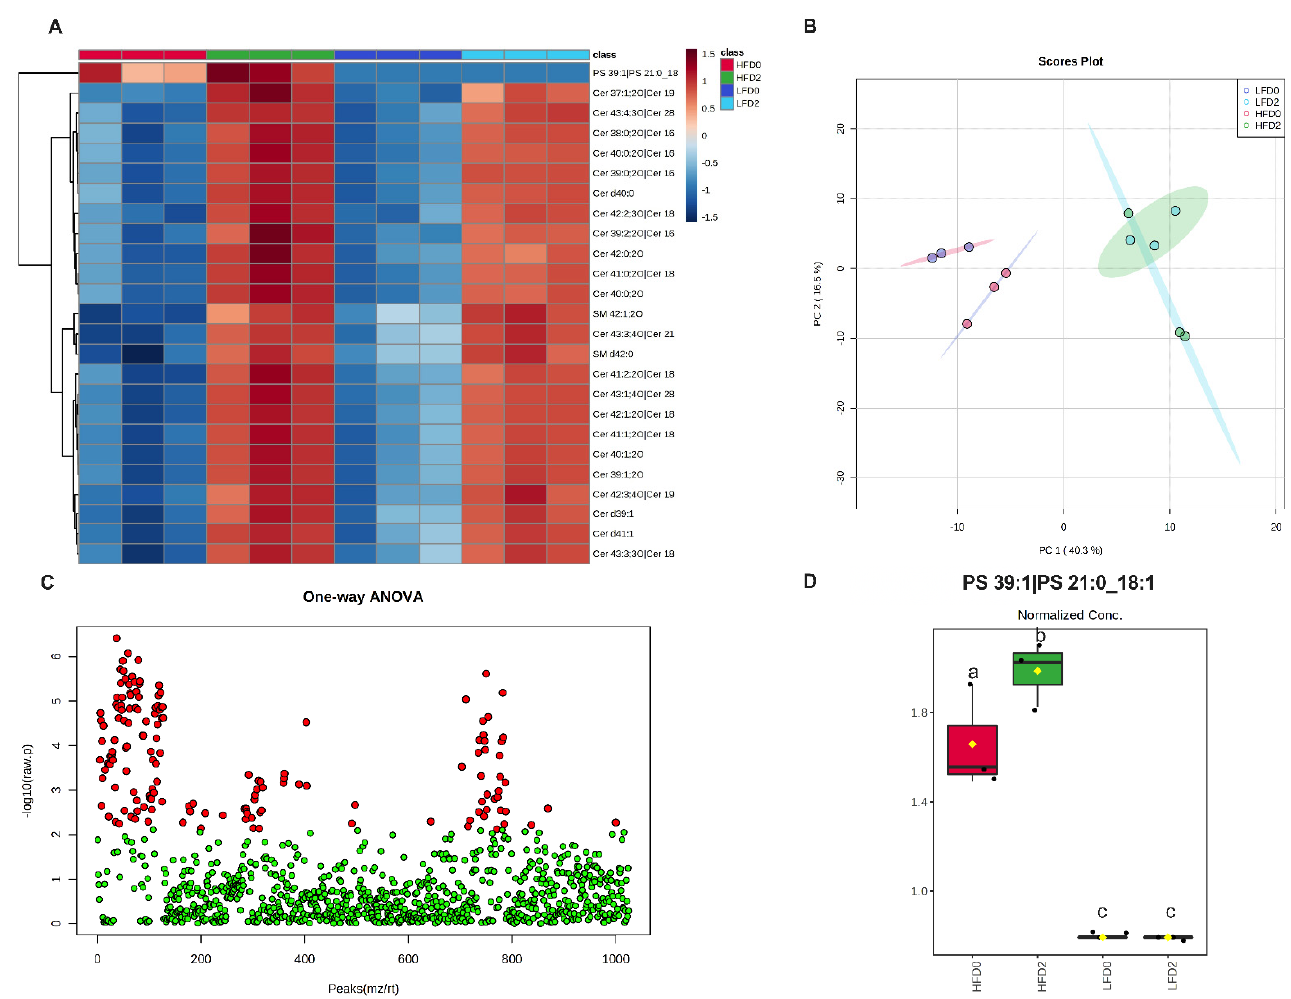
Figure 7. MPLs increase fecal ceramide and sphingolipid species in male mice. A heat map of the top 25 lipid species ( A ), PCA plot ( B ), one-way ANOVA plot ( C ), and phosphatidylserine (PS) 39:1 species ( D ) are shown. Data were normalized using log transformation and were analyzed using a one-way ANOVA with false discovery rate (FDR) q-value < 0.05 (n = 3/group). Values with unlike letters indicate differences at p < 0.05 using post-hoc comparisons. Abbreviations: Cer, Ceramide; SM, sphingomyelin.